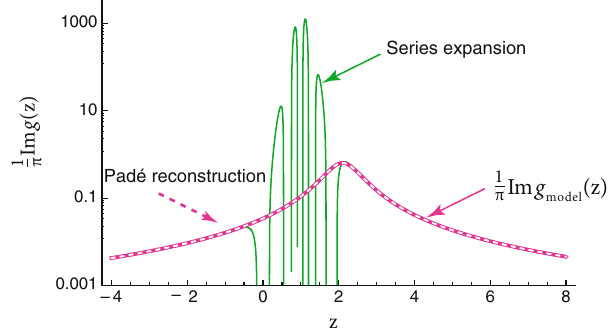
Figure 1. Reconstruction of g model ( z ) from its series expansion (1) in terms of g z ( ) model(0) using the Padé approximation (PA). Parameters are as follows: Δ = 1.1,  = 1, η = 0.5. The series expansion (1) is restricted at n max = 10, and PA is applied at the point z = 6. Notice that the original (magenta) and reconstructed (white) densities of states are practically